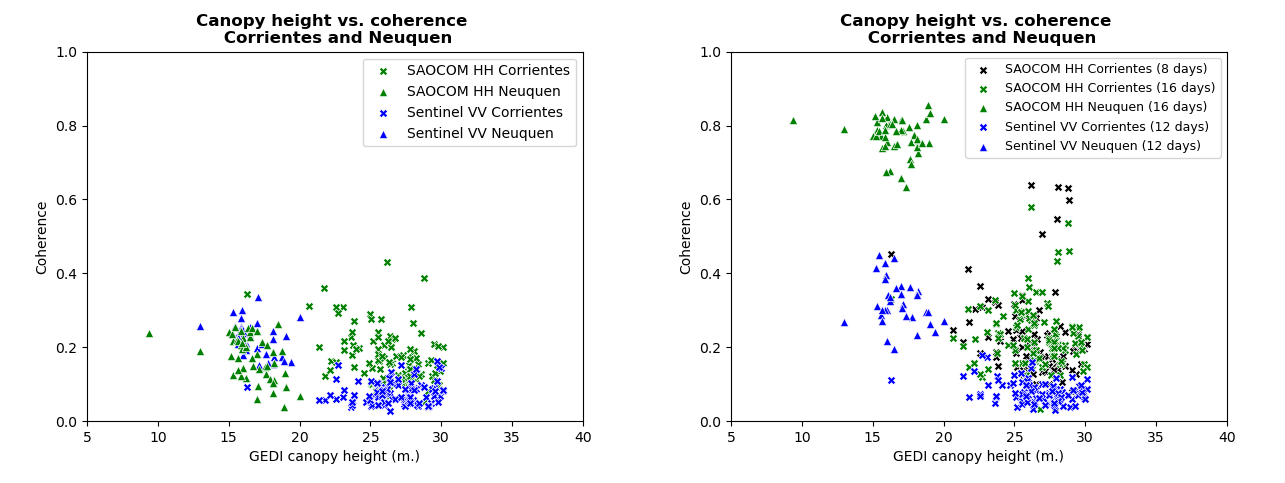
Figure 11. | γ | vs. GEDI canopy height for forests in Corrientes and Neuquén